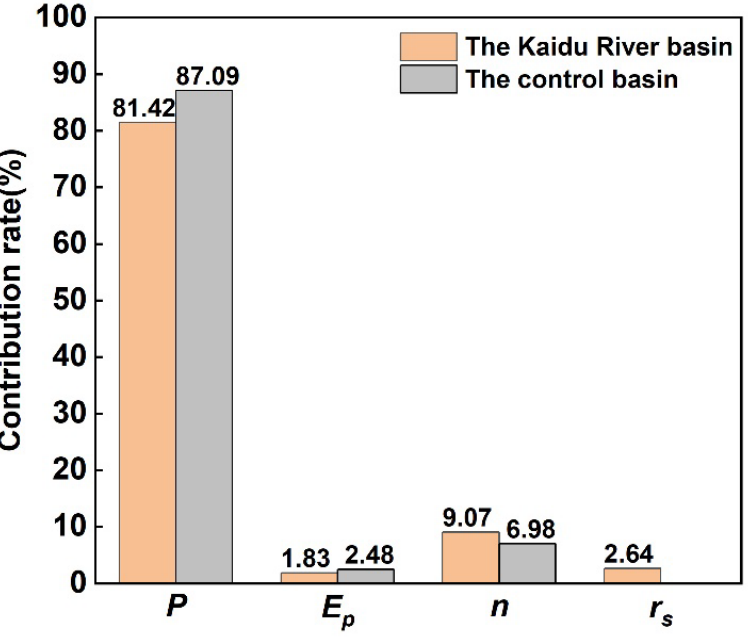
Figure 6. Contribution rate of precipitation ( P ), E P , snow ratio ( r s ), and basin parameter ( n ) changes to runoff variation in the two Budyko frameworks.